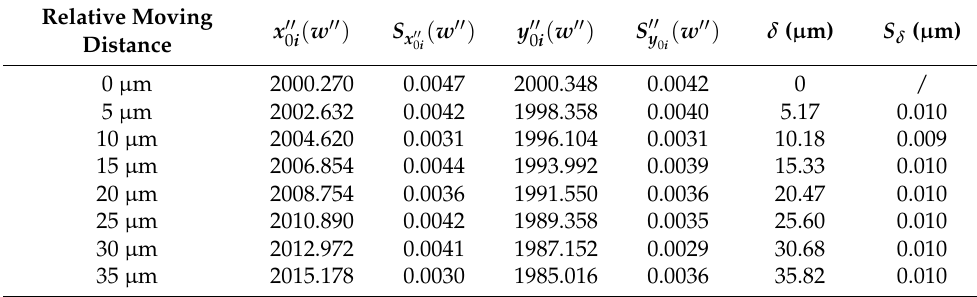
Table 5. Small range displacement experiment results at 35 µ m ( i best = 9).